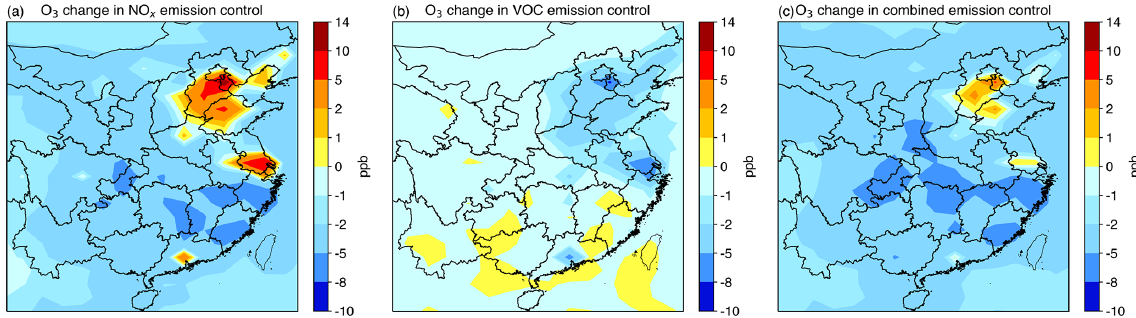
Figure 7. Spatial distributions of simulated surface daytime O 3 concentration changes (ppb) for (a) the 20% NO x emission control, (b) the 20% VOC emission control, and (c) the 20% combined NO x and VOC emission control compared to the present-day results in JJA, 2016, China. Table 4. Simulated daytime mean O 3 concentrations and changes (ppb) in NO x , VOC, and combined NO x and VOC emission controls for the six industrial regions in JJA, 2016, China. Region Base NO x control Change (%) VOC control Change (%) NO x + VOC control Change (%) Beijing 78.0 84.7 8.6% 72.5 − 7.0% 79.7 2.2% Shijiazhuang 83.5 86.6 3.8% 80.2 − 3.9% 84.6 1.4% Shanghai 70.1 77.8 11.0% 63.1 − 10.0% 69.4 − 1.0% Nanjing 66.8 72.4 8.5% 61.4 − 8.0% 67.8 1.6% Guangzhou 60.2 64.8 7.6% 53.8 − 10.7% 60.4 0.3% Chongqing 93.8 89.5 − 4.6% 92.5 88.5 −